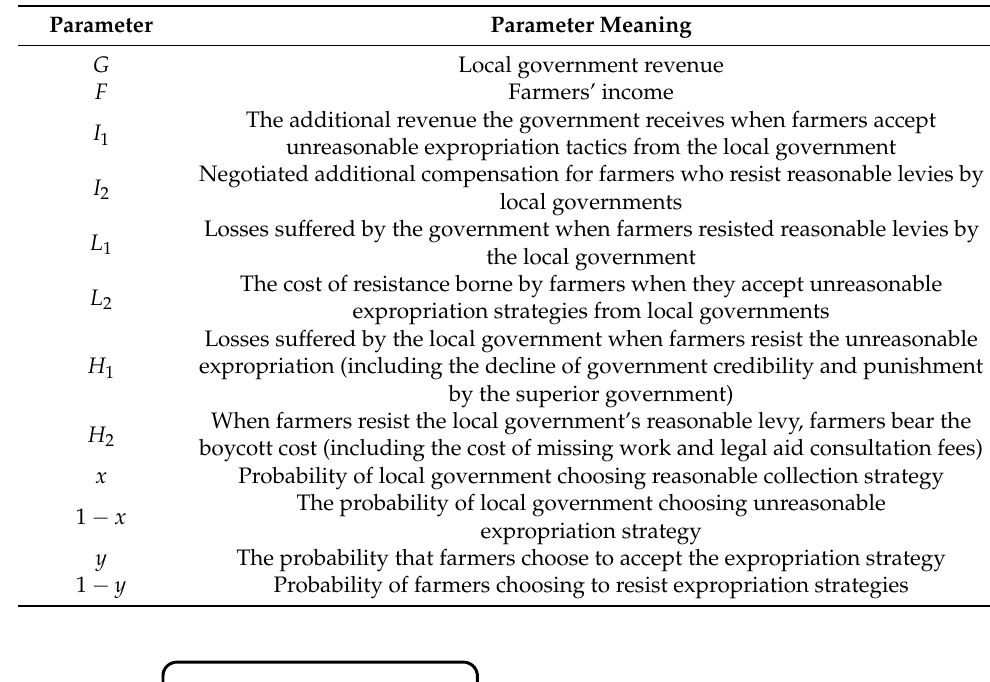
Table 1. Model Parameter Description.